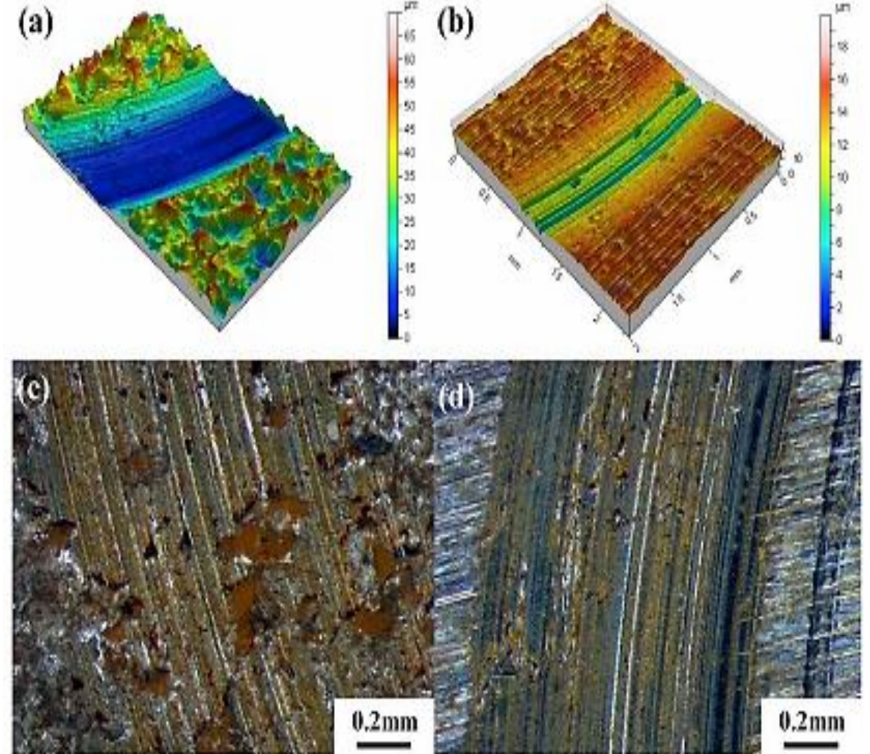
Figure 36. The microstructures of the worn patterns acquired during ball-on-disk testing on the as-cast samples ( a , c ) and austempered samples ( b , d )